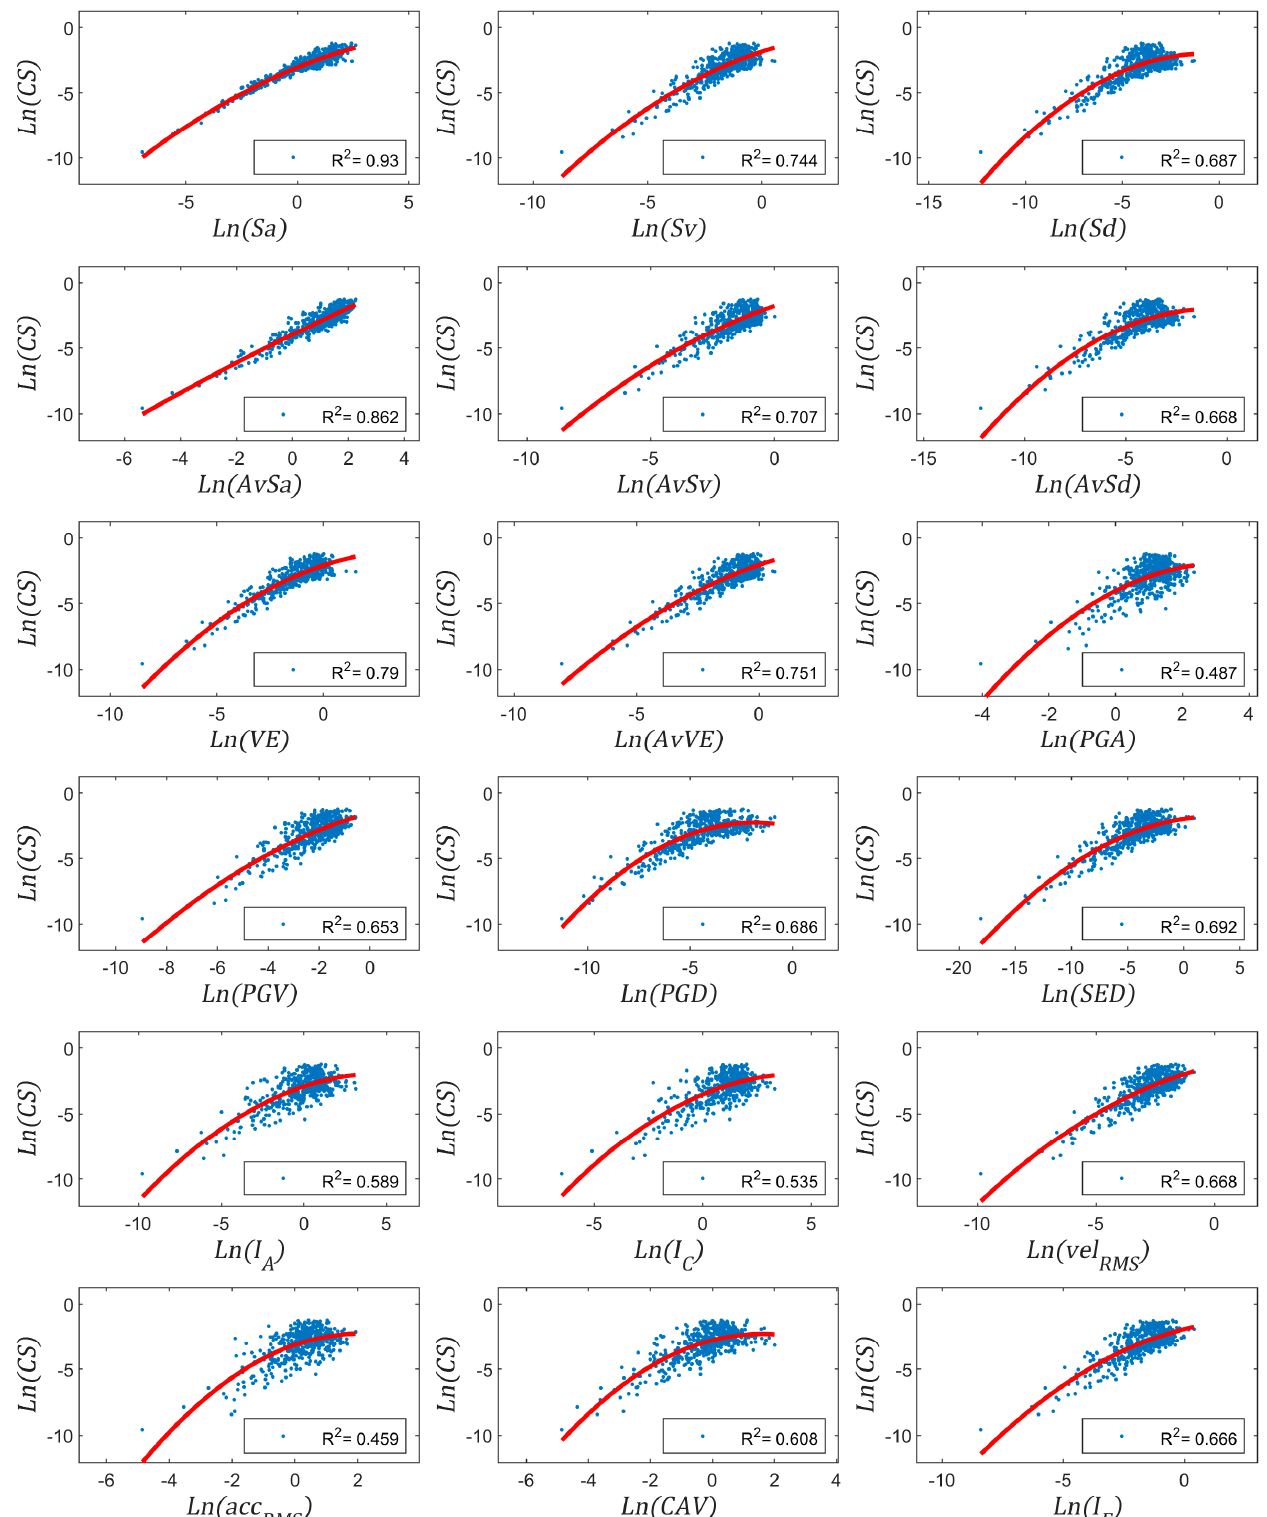
Figure 11. Correlation coefficient between IMs and CS in the log-log space for far-fault records.